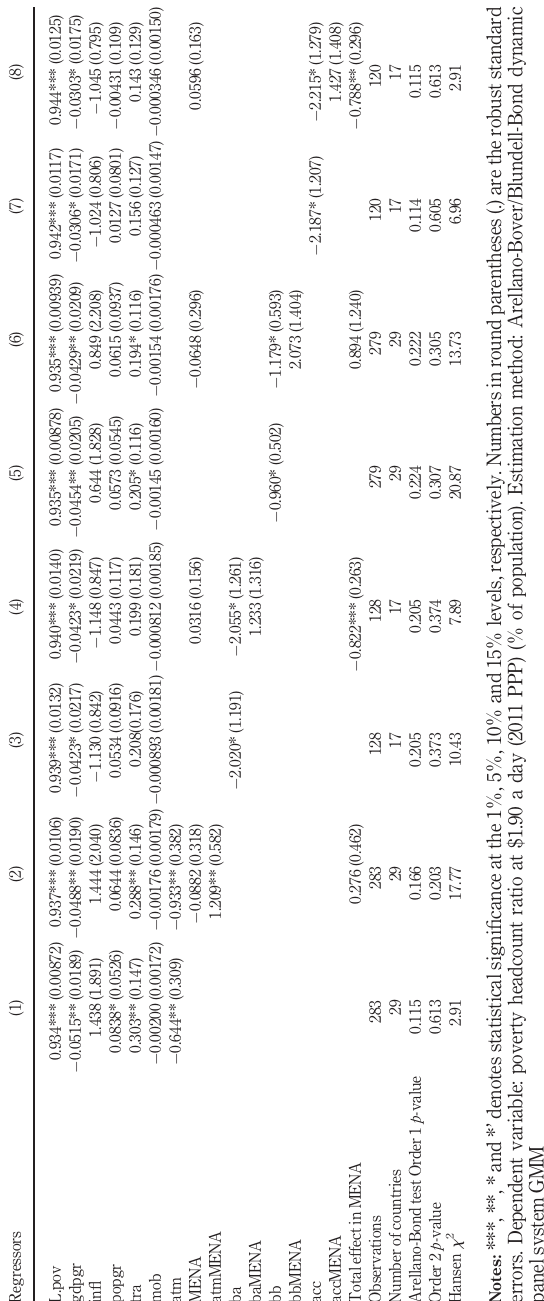
Table A6. Extreme poverty and financial access